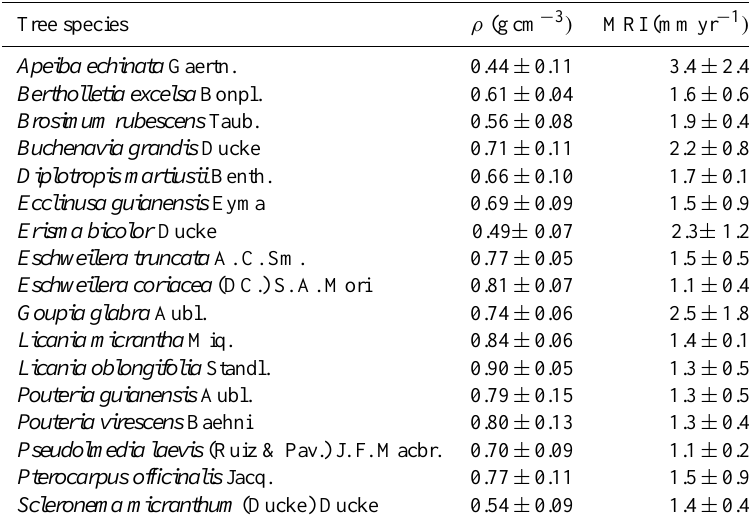
Table 4. Mean value and standard deviation of wood density ( ρ ) and mean radial increments (MRI) for characteristic tree species with five or more individuals in the study sites.